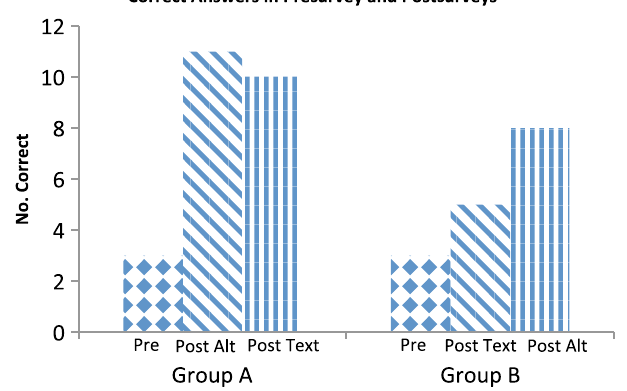
FIG. 7. Number of correct answers in the Presurvey and